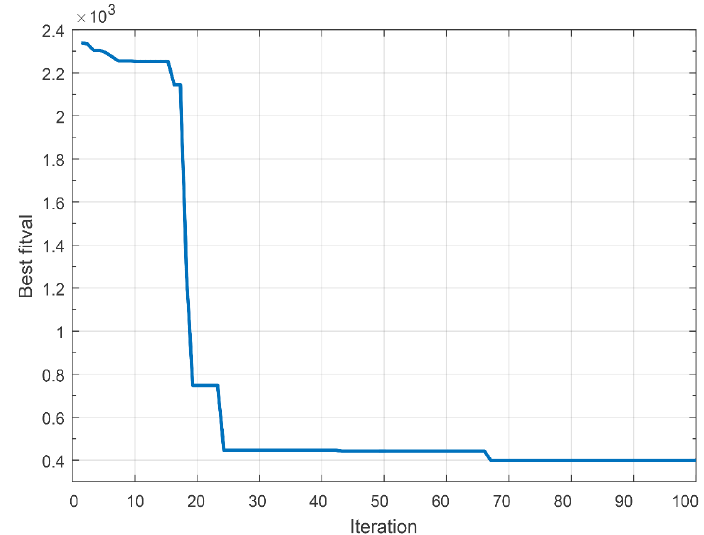
Figure 9. Conversion of fuzzy logic controller (FLC) optimization using ABC by 100 iterations. Table 3. Optimal scaling factors for FLC obtained from ABC optimization algorithm .